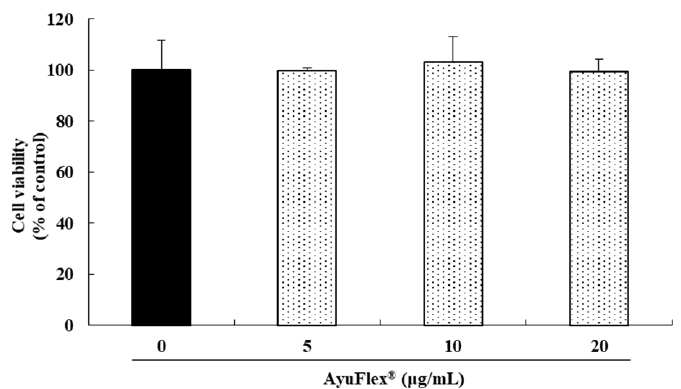
Figure 1. Effects of AyuFlex ® on cell viability in primary human chondrocytes (HCHs). HCHs were treated with each concentration of AyuFlex ® (5, 10, and 20 μ g/mL) for 24 h. Cell viability was evaluated utilizing the 3-(4, 5-dimethylthiazol-2-yl)-2, 5-diphenyl tetrazolium bromide (MTT) assay. 3.2. AyuFlex ® Repressed the Expression of iNOS, 5-LOX, LTB 4 , and IL-6 in IL-1 β -Treated HCHs